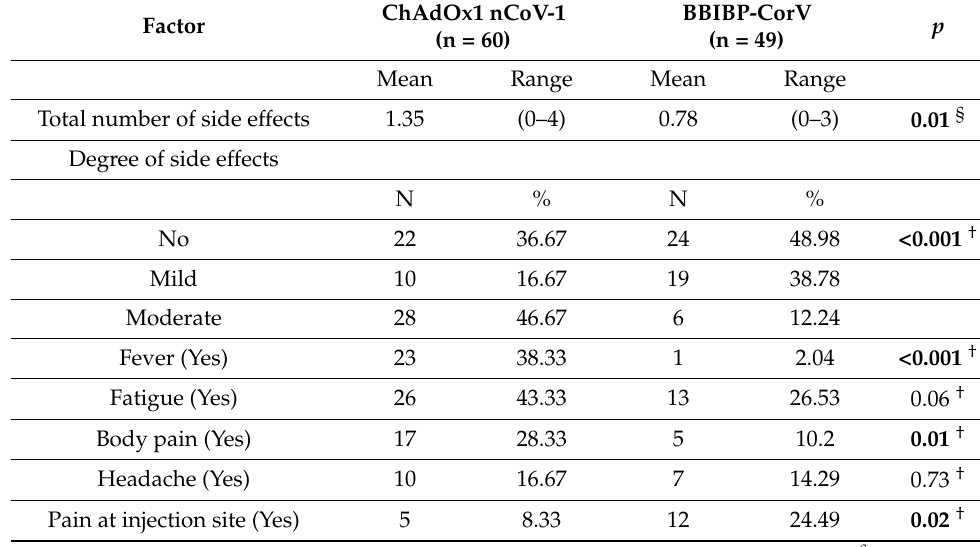
Table 5. Side effects of vaccination (n =